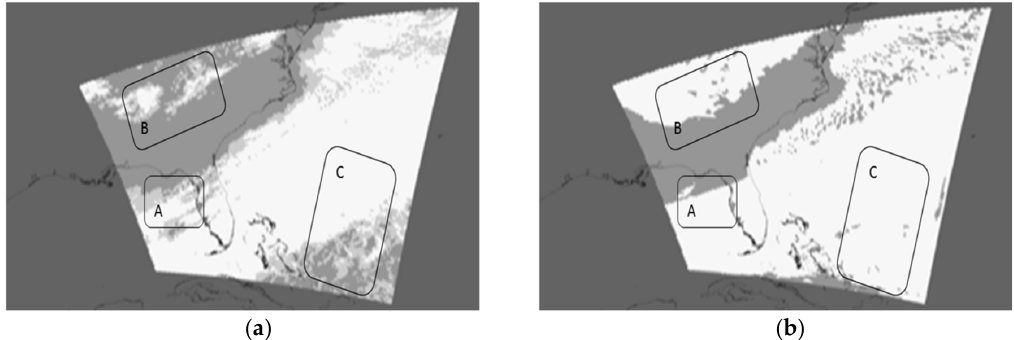
Figure 4. Comparisons between CCf truth and baseline CCf WRF results at 1800 UTC on 19 Nov 2014. ( a ) Mean CCf truth for all clouds in the VIIRS data after mapping the MGCNC image to the WRF grid and ( b ) CCf WRF for all clouds in the baseline 24 h WRF simulation based upon CLDFRAmax at each WRF grid for all eta levels. Legends are identical to those used in Figure 3.